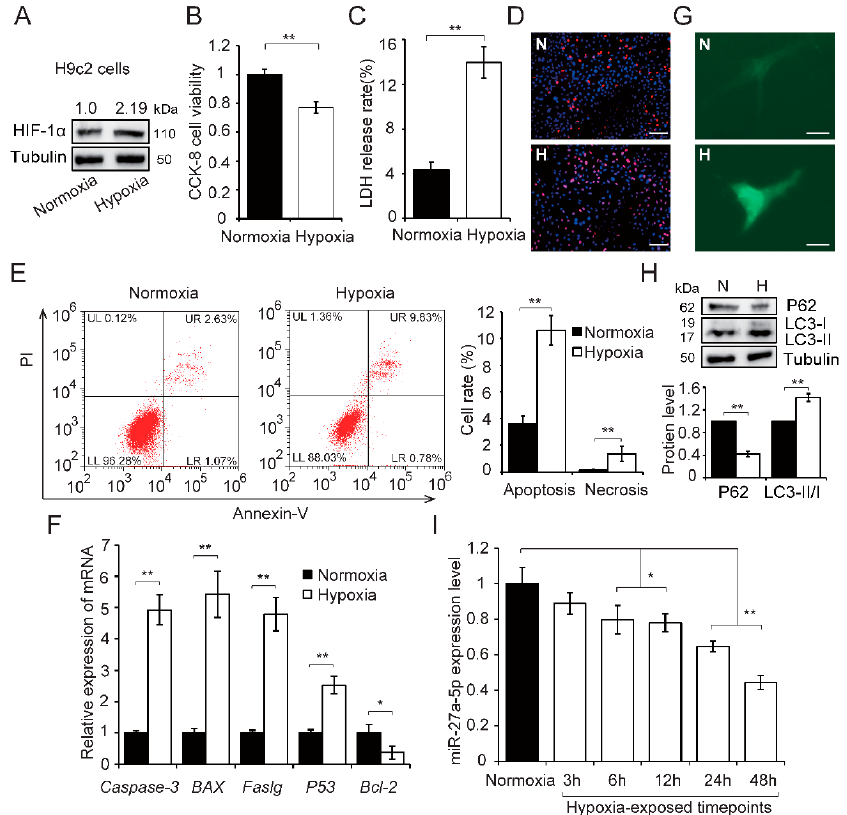
Figure 2. Hypoxia induces H9c2 cell injury and downregulation of miR-27a-5p. H9c2 cells were cultured under hypoxia or normoxia for 24 h. HIF-1 α protein increased in H9c2 cells after hypoxia ( A ). Cell viability ( B ), membrane damage ( C ), and cell apoptosis ( D – F ) were evaluated by CCK8 assay, LDH release assays, apoptosis staining (scale bar: 50 µ m), flow cytometry, and qRT-PCR analysis, respectively. H9c2 cells were transfected with GFP-LC3 plasmids and exposed to hypoxia for 24 h, fluorescence was observed by confocal fluorescence microscopy ( G ); scale bar: 5 µ m. The autophagy-related proteins were detected by western blot ( H ). The expression of miR-27a-5p was tested using qRT-PCR at di ff erent hypoxia-exposed timepoints ( I ). Three independent experiments were performed in triplicate. Data are expressed as the mean ± SD. * p < 0.05, ** p < 0.01. N: normoxia; H: